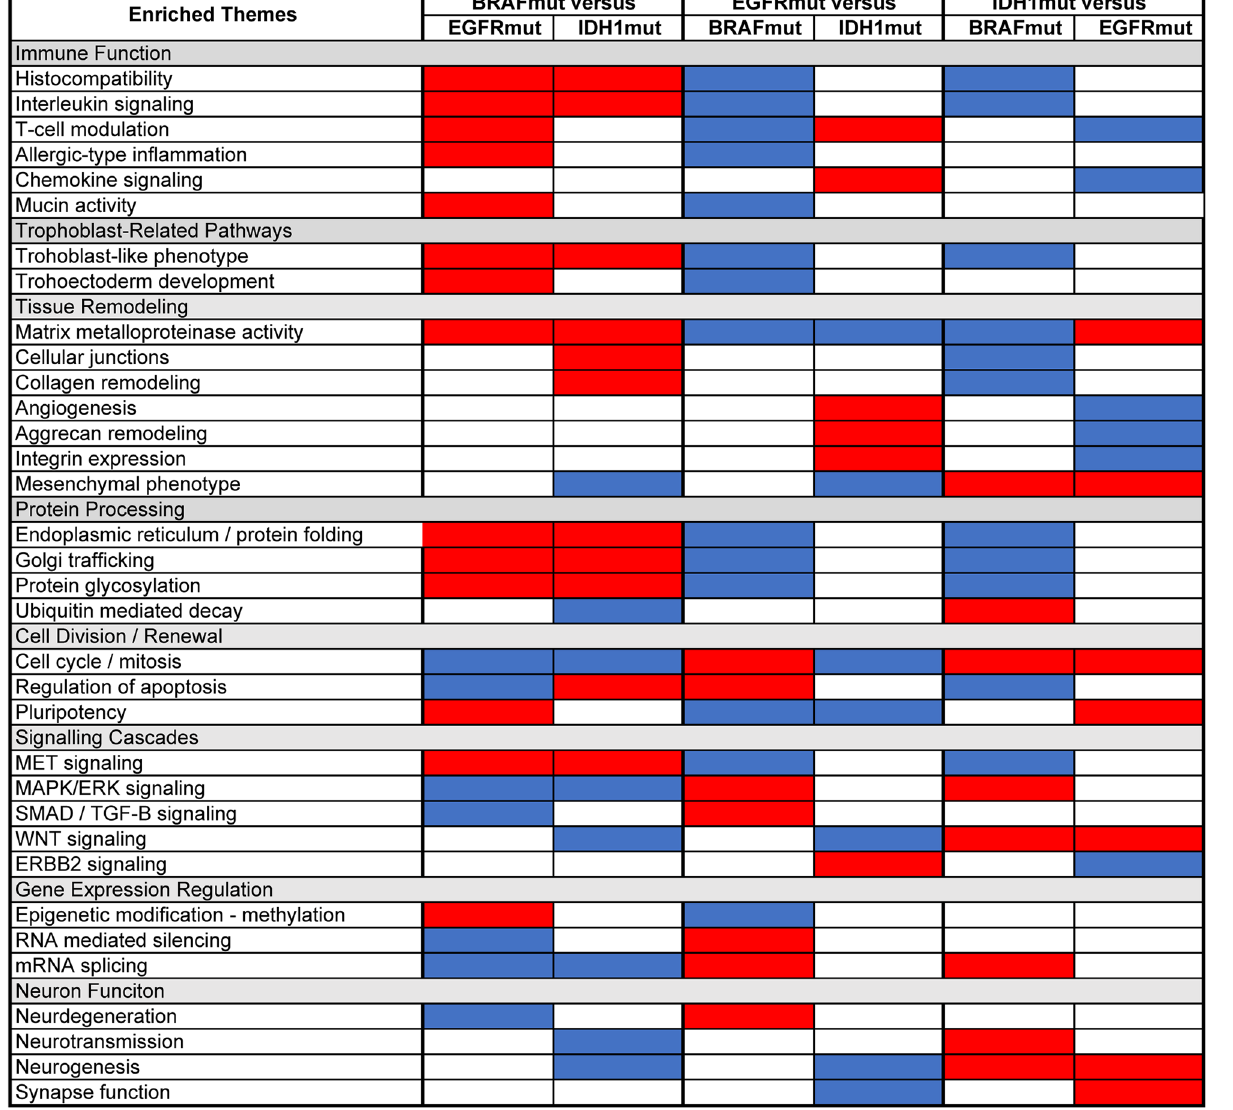
Figure 4. Biological concepts and themes enriched among genes differentially expressed between tumors gain-of-function mutation in BRAF , EGFR , or IDH1. A pseudo-heatmap was constructed from the comparison of biological themes associated with the differentially expressed genes identified from a microarray based study of gene expression profiles among glioblastoma with gain-of-function mutations in BRAF , EGFR and IDH1 . Related biological themes that were associated with each list of differentially expressed genes (illustrated in Supplemental Fig. 1) were grouped into higher-level clusters to facilitate comparison between the three subgroups. Red indicates increased expression; blue indicates decreased